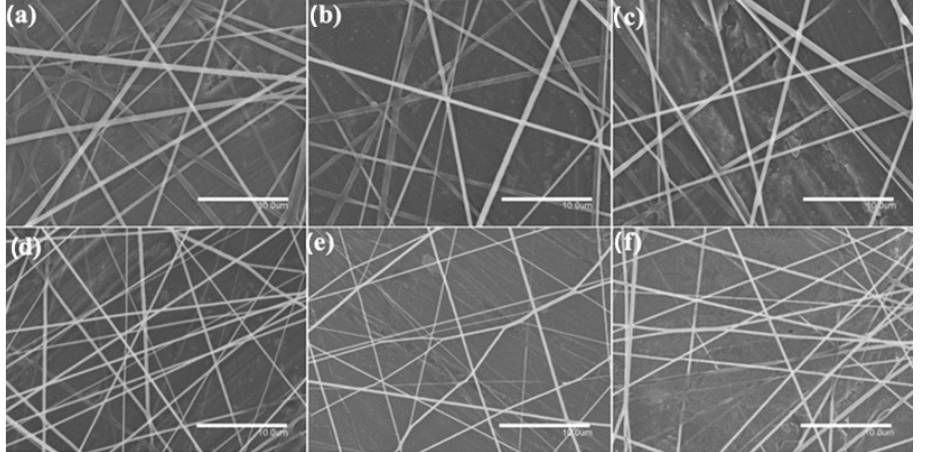
Figure 3. Comparison of the morphology of the electrospun poly(3-hydroxybutyrate-co-3-hy- droxyvalerate) (PHBV) fibers: ( a ) 0.5 wt.% CeO 2 NPs + CTAB; ( b ) 1.0 wt.% CeO 2 NPs + CTAB; ( c ) 1.5 wt.% CeO 2 NPs + CTAB; ( d ) 2.0 wt.% CeO 2 NPs + CTAB; ( e ) 5.0 wt.% CeO 2 NPs + CTAB; ( f ) 10.0 wt.% CeO 2 NPs + CTAB. Micrographs were taken by scanning electron microscopy (SEM). Scale bar 10 µm.